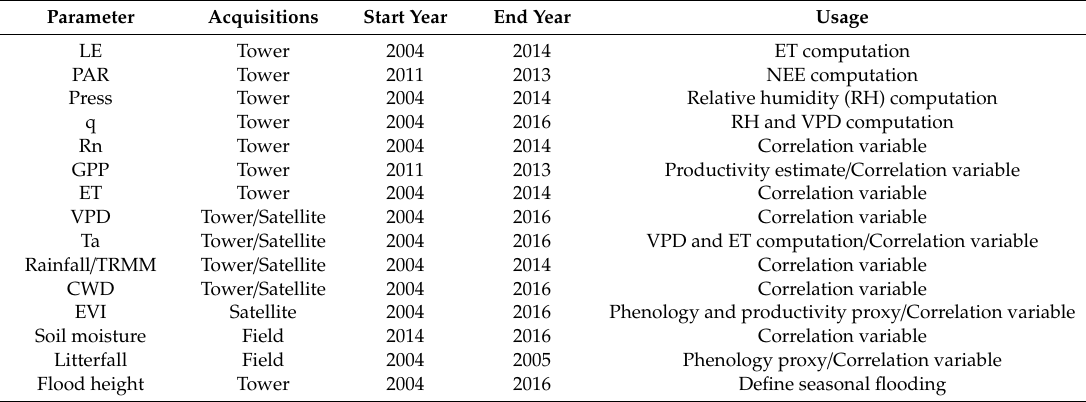
Table 1. Availability and usage description of tower, satellite and field